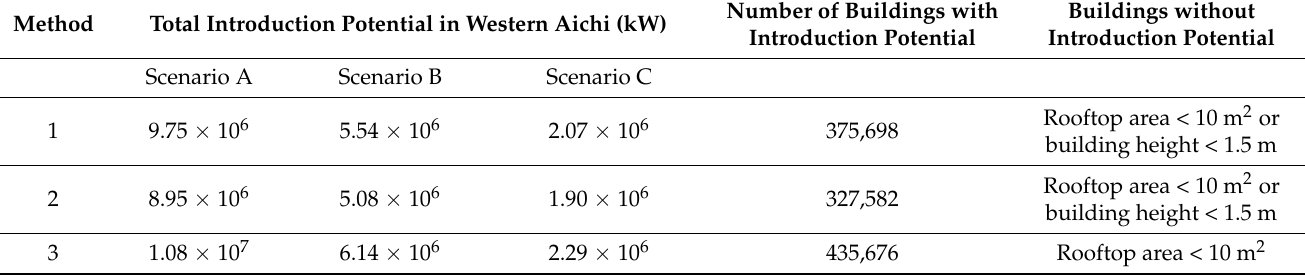
Table 4. Total introduction potential of solar PV in western Aichi by three methods under each